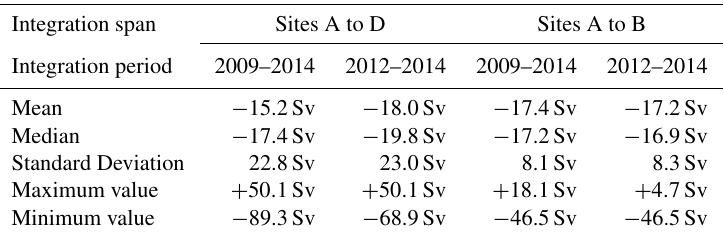
Figure 11. Same as Fig. 9, except that the transport time series used for identifying strong and weak southward transport days was integrated only between sites A and B (i.e., the record in Fig. 10) instead of between sites A and D. White contours in all panels indicate zero flow. Table 4. Statistics for the volume transport calculated from the PIES and GEM data across the whole array (columns 2 and 3) versus only within the span between sites A and B (columns 4 and 5). Note that column 2 is identical to column 2 in Table 2. The transports were integrated from between the indicated sites (see Table 1) and from 800 down to 4800dbar (or the bottom where it is shallower). Statistics are shown for both the period 2009 to 2014 (columns 2 and 4) and during the enhanced array period 2012–2014 (columns 3 and 5). The transports were calculated using only the original PIES moorings; the results in the enhanced period are very similar if the CPIESs are also included, as is to be expected for geostrophic calculations.